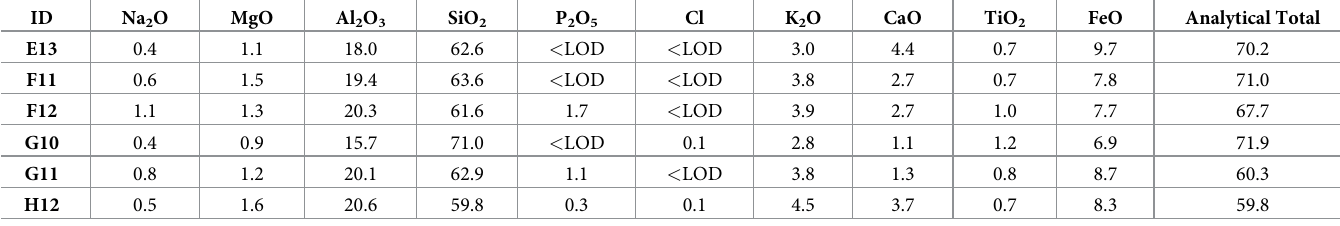
Table 2. SEM-EDS results (wt%) of bulk ceramic